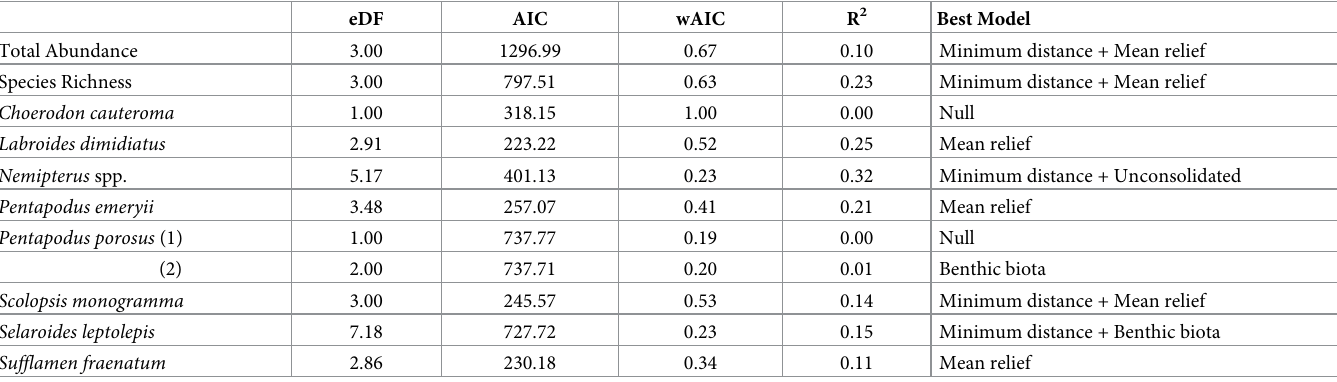
eDF, estimated degrees of freedom; AIC, Akaike Information Criterion; wAIC, Weighted Akaike Information Criterion. If the best model was Null, the second best model was reported if it was within 2 AIC of the Null